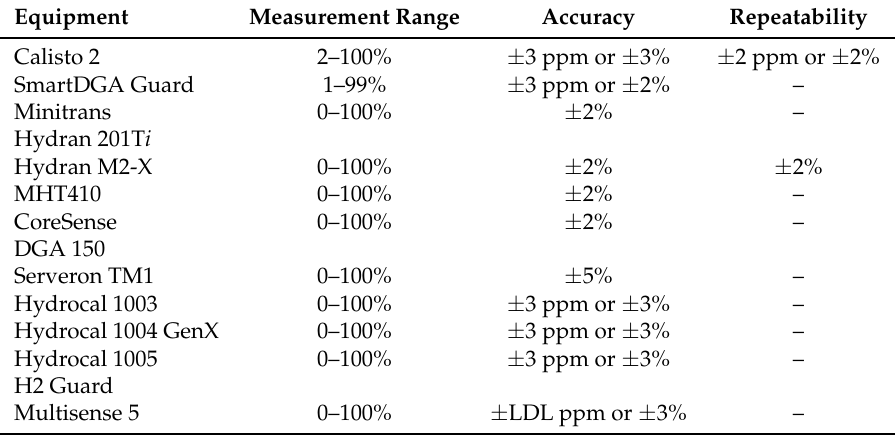
Table 9. Moisture measurement range and accuracy of fault detection monitors (as indicated by